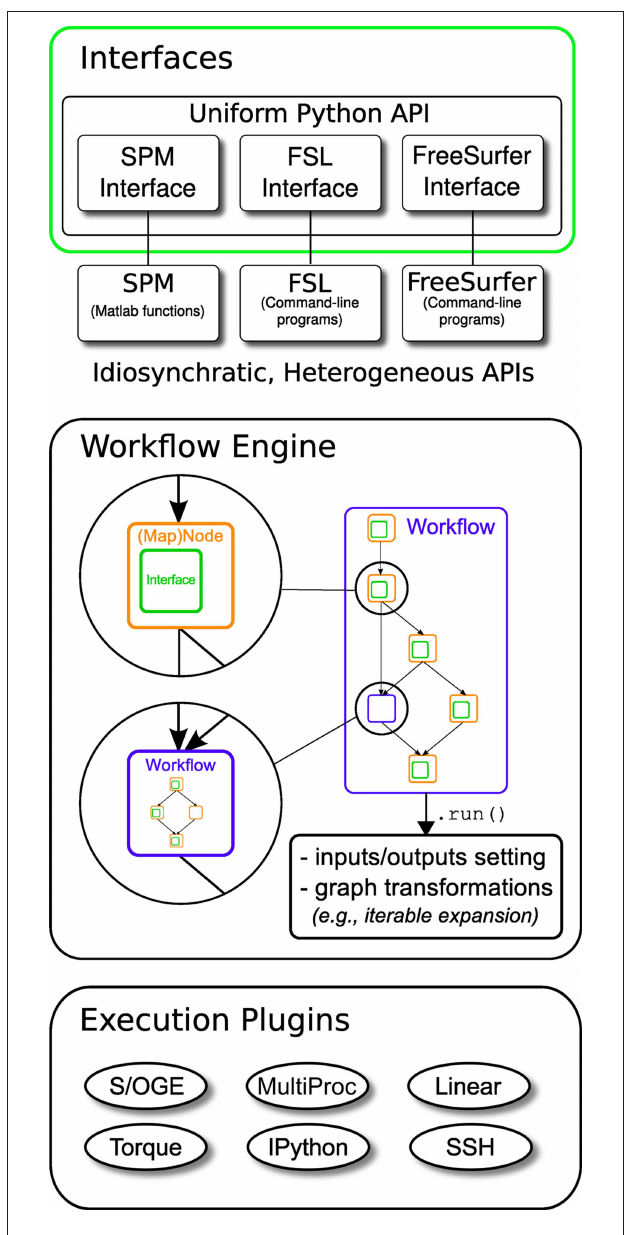
FiGure 1 | Architecture overview of the Nipype framework. Interfaces are wrapped with Nodes or MapNodes and connected together as a graph within a Workflow. Workflows themselves can act as a Node inside another Workflow, supporting a composite design pattern. The dependency graph is transformed before being executed by the engine component. Execution is performed by one of the plug-ins. Currently Nipype supports serial and parallel (both local multithreading and cluster) execution.